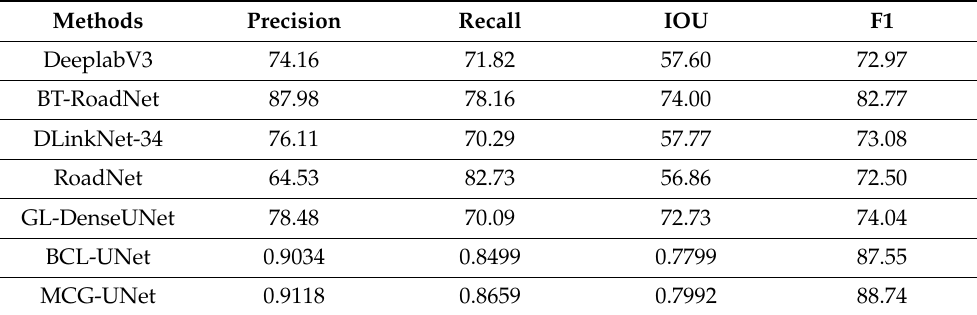
Table 4. Quantitative results generated by the BCL-UNet and MCG-UNet and other deep learning- based techniques for road